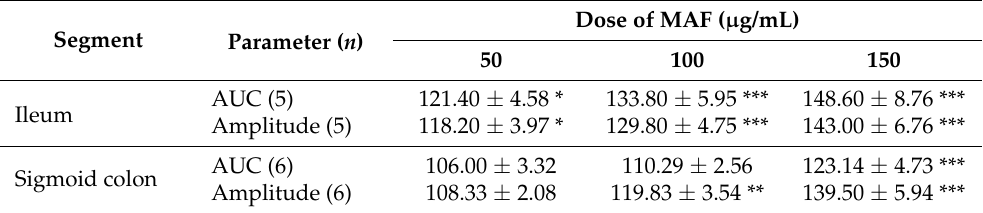
Figure 5. Effects of MAF on EFS-induced contractions of smooth muscle strips in human sigmoid colon in situ. ( A ) Representative raw traces showing that MAF increased electrically evoked contractions by neural stimulation in a dose-dependent manner (50–150 µg/mL). Dots and arrows indicate the points of EFS application and MAF administration, respectively. Summarized graphs showing the effects of MAF on ( B ) AUC and ( C ) amplitude of contractions. Significant difference (** p < 0.01 and *** p < 0.001) compared with control. Table 2. Relative values of AUC and amplitude (% of control) for EFS-induced contractions after treatment with each dose of MAF in human ileal and colonic smooth muscle strips in situ.